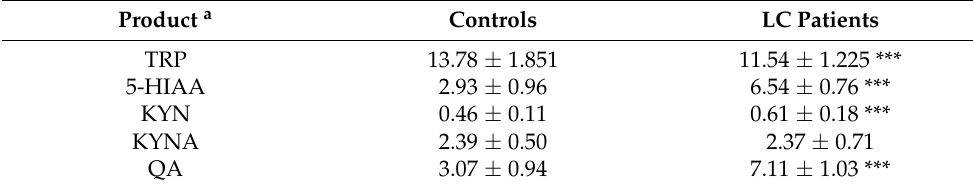
Table 2. Concentration of tryptophan (TRP) and main products of its metabolism in the kynurenine pathway in urine of controls ( n = 40) and lymphocytic colitis (LC) patients ( n = 60) enrolled in this study.